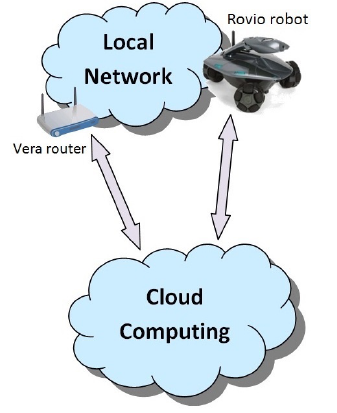
Figure 1. Cloud robotics